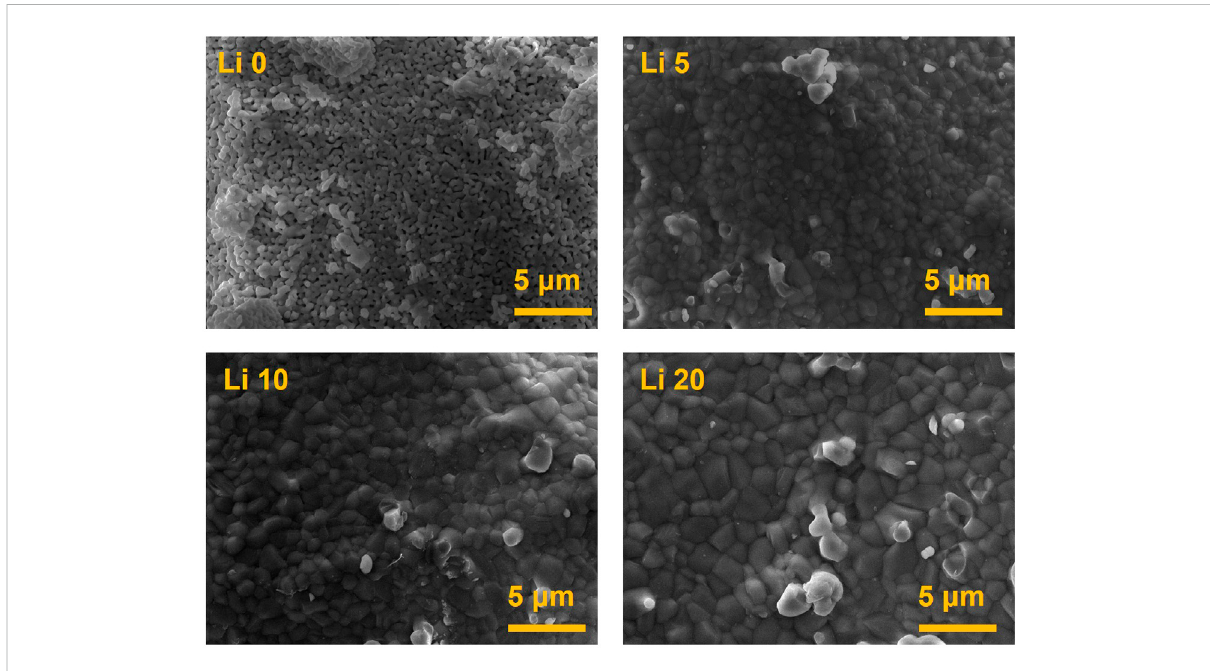
FIGURE 5 Morphologies of the pure BCP and Li-BCP powders after calcined at 1,000 ° C.